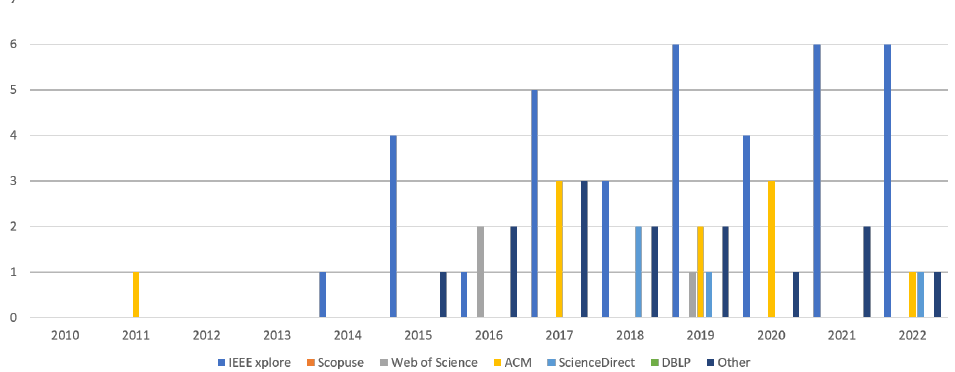
Figure 6. Distribution of papers by year and Journal.